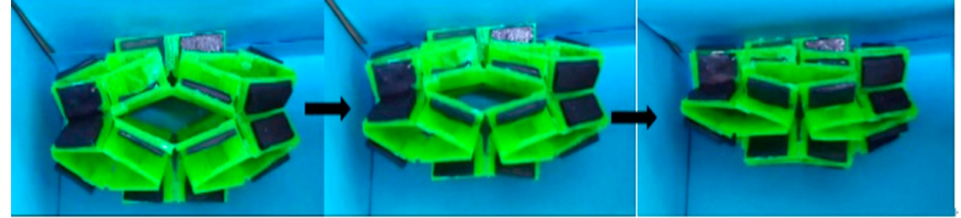
Figure 9. Magnetically driven shape shifting of the origami